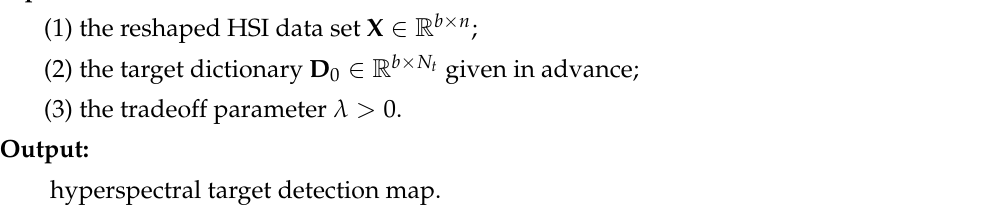
Algorithm 1 The proposed DLcMD